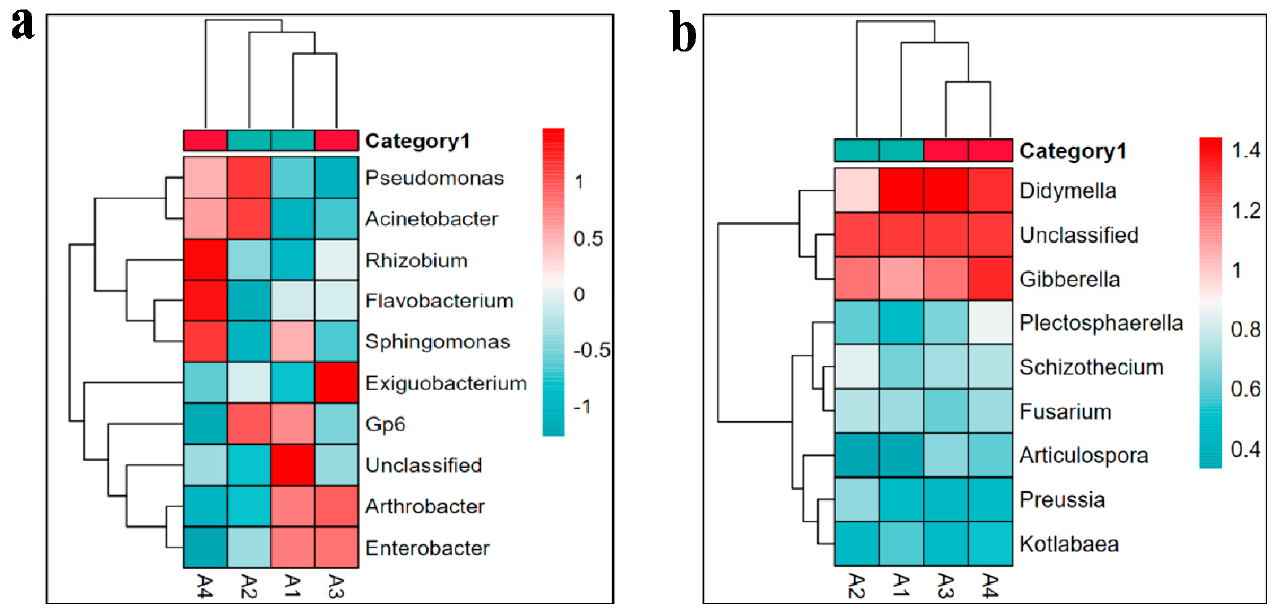
Figure 7. Abundance of community composition at the soil microbiota genus level. Note: ( a ) repre- sents bacterial abundance heat map, ( b ) represents fungal abundance heat map